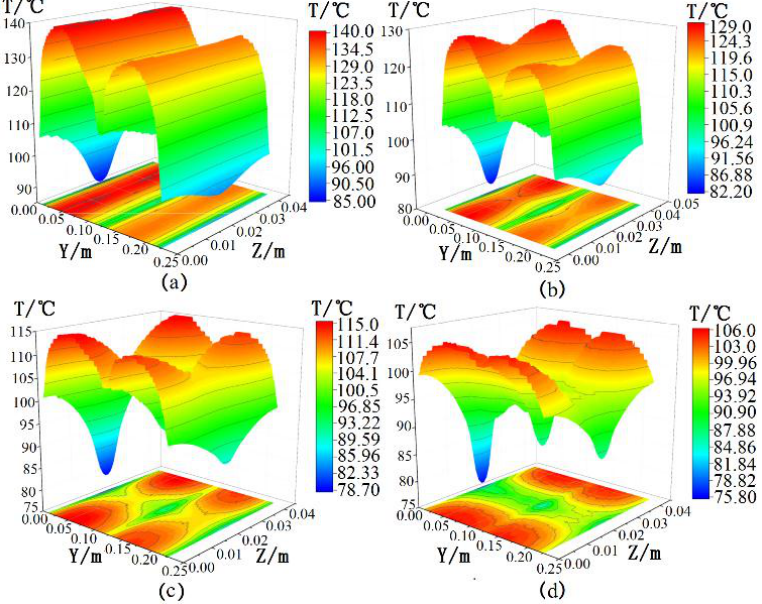
Figure 6. The main insulation axis–radial temperature distribution in the un-shelling side in the stator main insulation unilateral shelling δ = 0.5 mm: ( a ) The main insulation axial–radial P 9 temperature distribution; ( b ) The main insulation axial–radial P 10 temperature distribution; ( c ) The main insulation axial–radial P 11 temperature distribution; ( d ) The main insulation axial–radial P 12 temperature distribution.